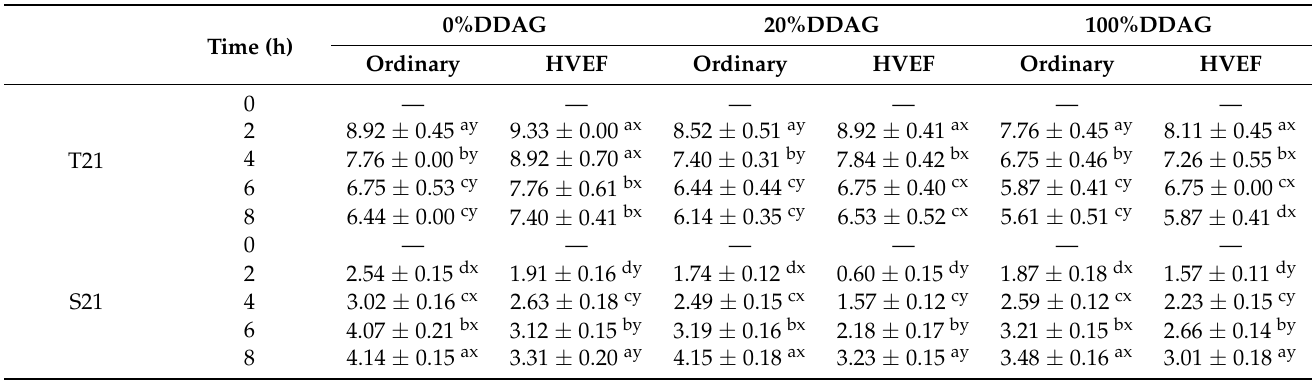
Table 4. The T 21 and S 21 of 0%DDAG, 20%DDAG, and 100%DDAG during ordinary heating and HVEF heating at 180 °C for 8